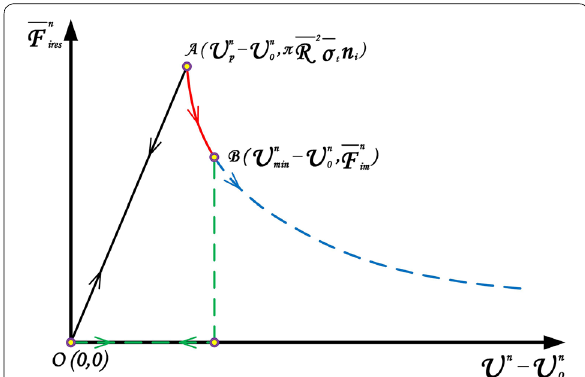
Fig. 4 Relation between strength and deformation for simplified residual strength